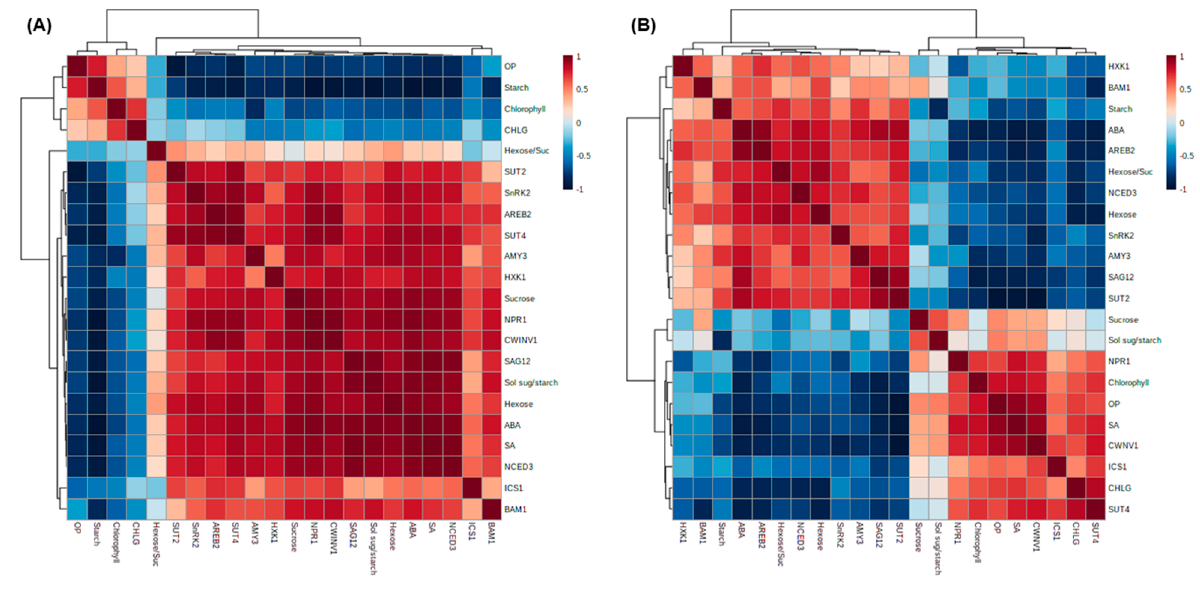
Figure 7. Heatmap showing the correlations among the identified hormones, metabolites, and gene expression during the early period (days 0–6; ( A )) and late period (days 6–14; ( B )). The correlation coefficients were calculated based on Pearson’s correlation. Red indicates positive effects, whereas blue indicates negative effects. The color intensity is proportional to the correlation coefficients. Suc: sucrose and Sol sug: soluble sugars.